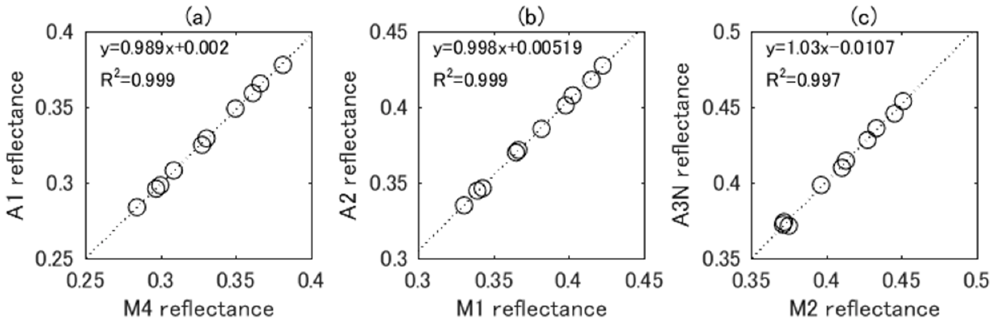
Figure 3. Scatter plots of soil reflectances of the Railroad Valley Playa over ASTER-MODIS